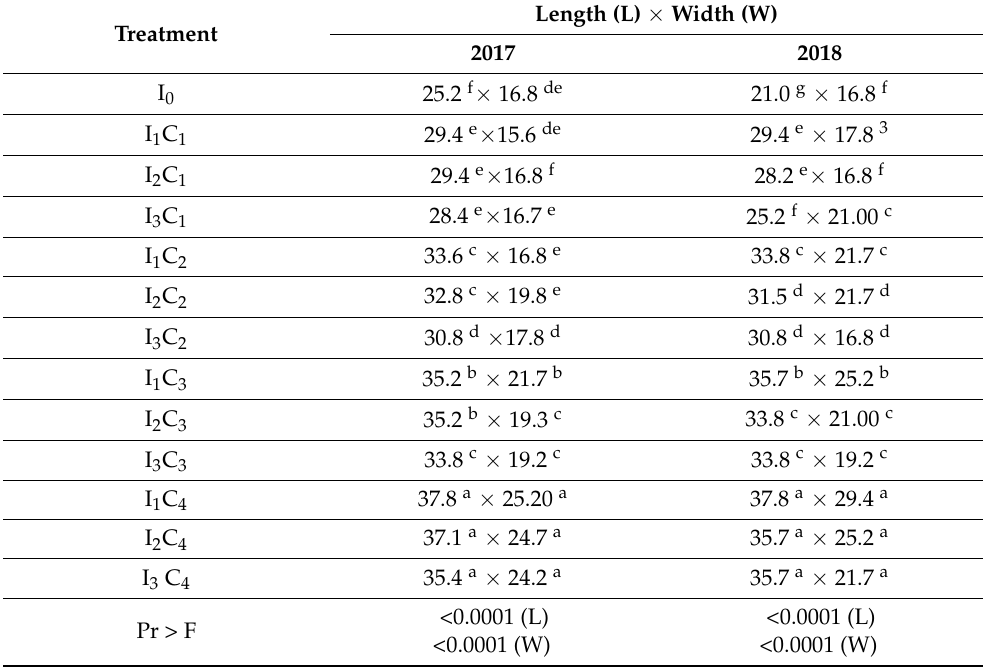
Table 8. Effect of different irrigation levels at various crop phenological stages on leaf nutrient content. Irrigation Level (I)